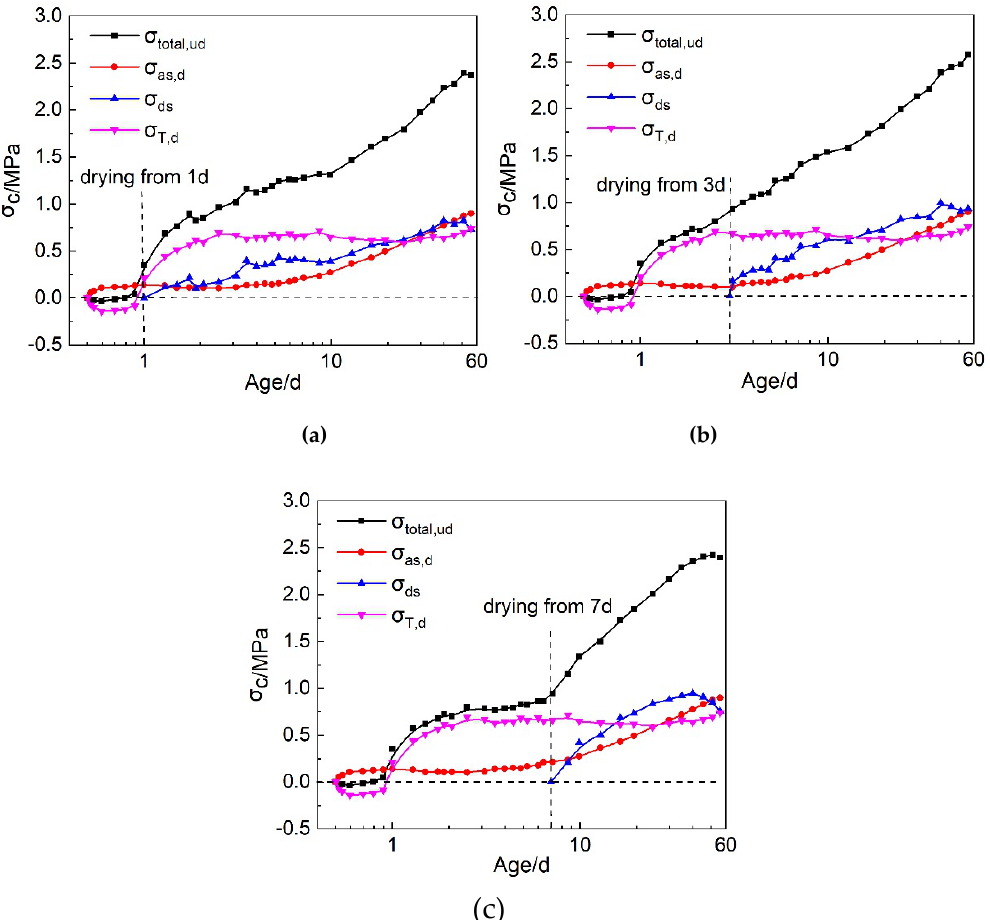
Figure 9. The development of the autogenous shrinkage stress, drying shrinkage stress, thermal stress and the total restrained stress under U-streel restraint and di ff erent drying conditions: ( a ) Drying from 1 d; ( b ) Drying from 3 d; ( c ) Drying from 7